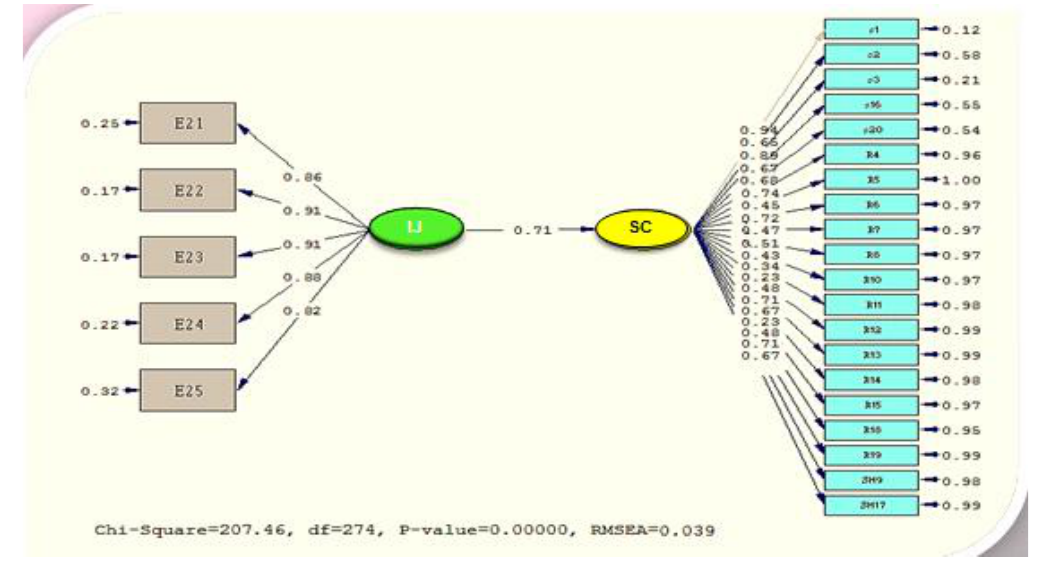
Fig. 2: Confirmatory factor analysis of research primary hypothesis